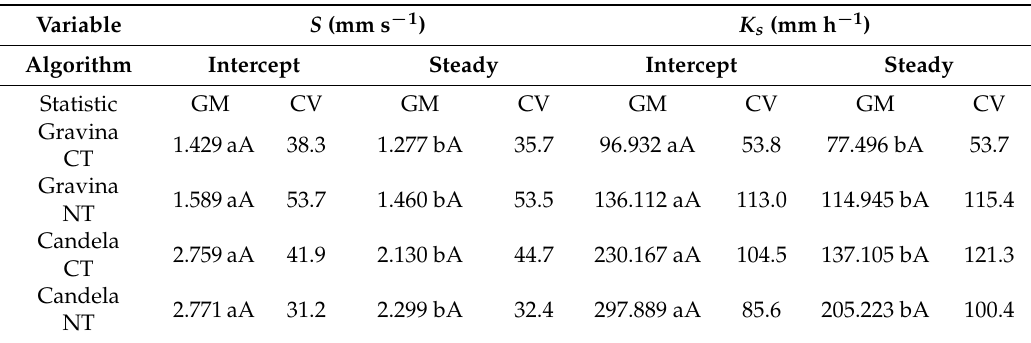
Table 4. Geometric mean (GM) and associated coefficient of variation (CV%) of soil sorptivity ( S ) and saturated hydraulicconductivity ( K s ) obtainedfor eachBEST-algorithm (Intercept and Steady), experimental site (Gravina and Candela) and soil management (conventional tillage, CT and no-tillage, NT).